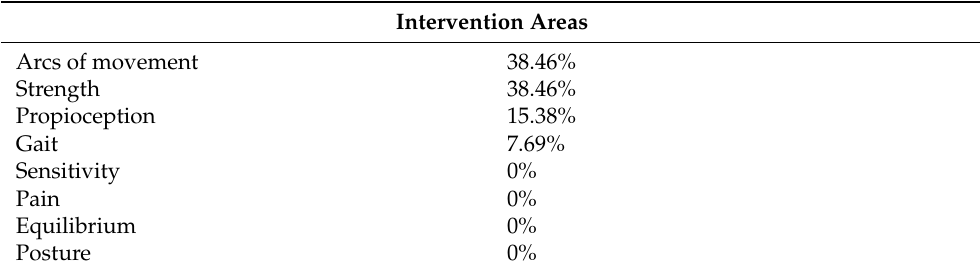
Figure 9. Perceptions about Kina ’s interface and data reports. Table 9. Therapeutic objectives related to intervention areas in which physiotherapist consider Kina could be useful.